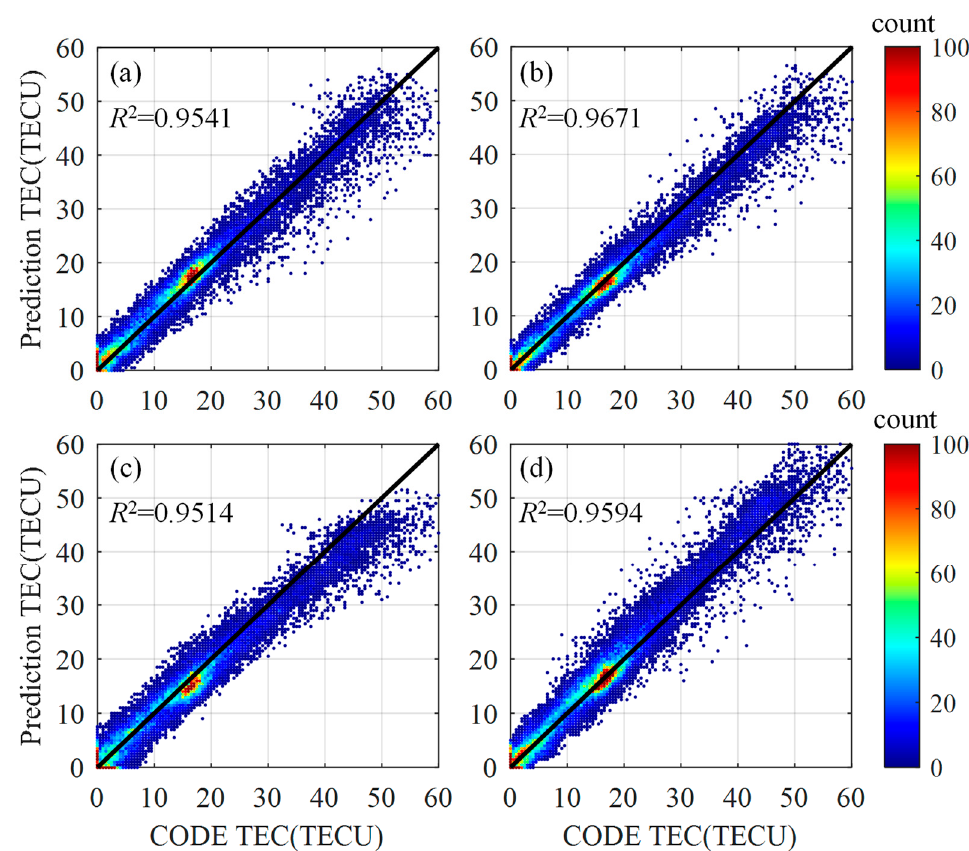
Figure 9. Correlation analysis between forecasted values and CODG values on 2 June in a year of high solar activity. ( a – c ) Scatter density plots of the correlations between the 7-day, 15-day and 30-day Prophet model forecasted values, respectively, and the CODG values. ( d ) Scattered density plot of the correlation between the COPG and CODG values.